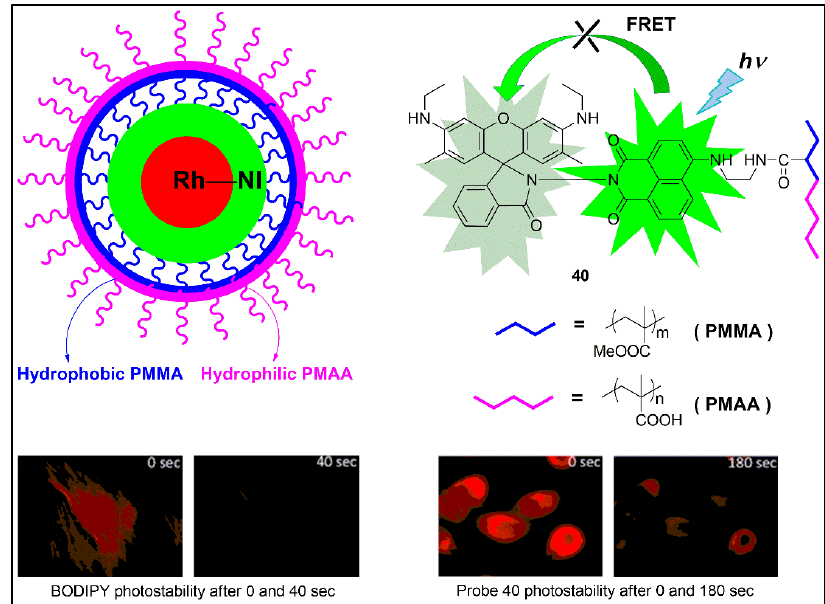
Figure 41. Self-assembly of the FRET-based probe 40 into water-soluble micelles in an aqueous solution. Photostability comparison of the stained HeLa cells by using (left panel) pure BODIPY- labeled actin and (right panel) probe 40 micelles internalized in HeLa cells. Images were taken after different time intervals of continually intense excitation. Adapted with permission from [125]. Copyright (2013)